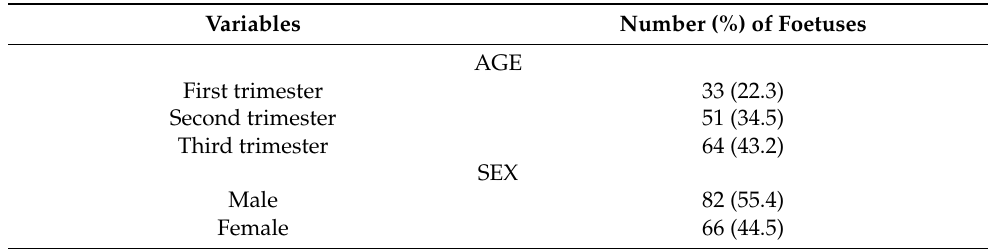
Table 5. Age and sex distribution of foetuses ( n = 148) recovered from pregnant cows slaughtered in Southeast, Nigeria.